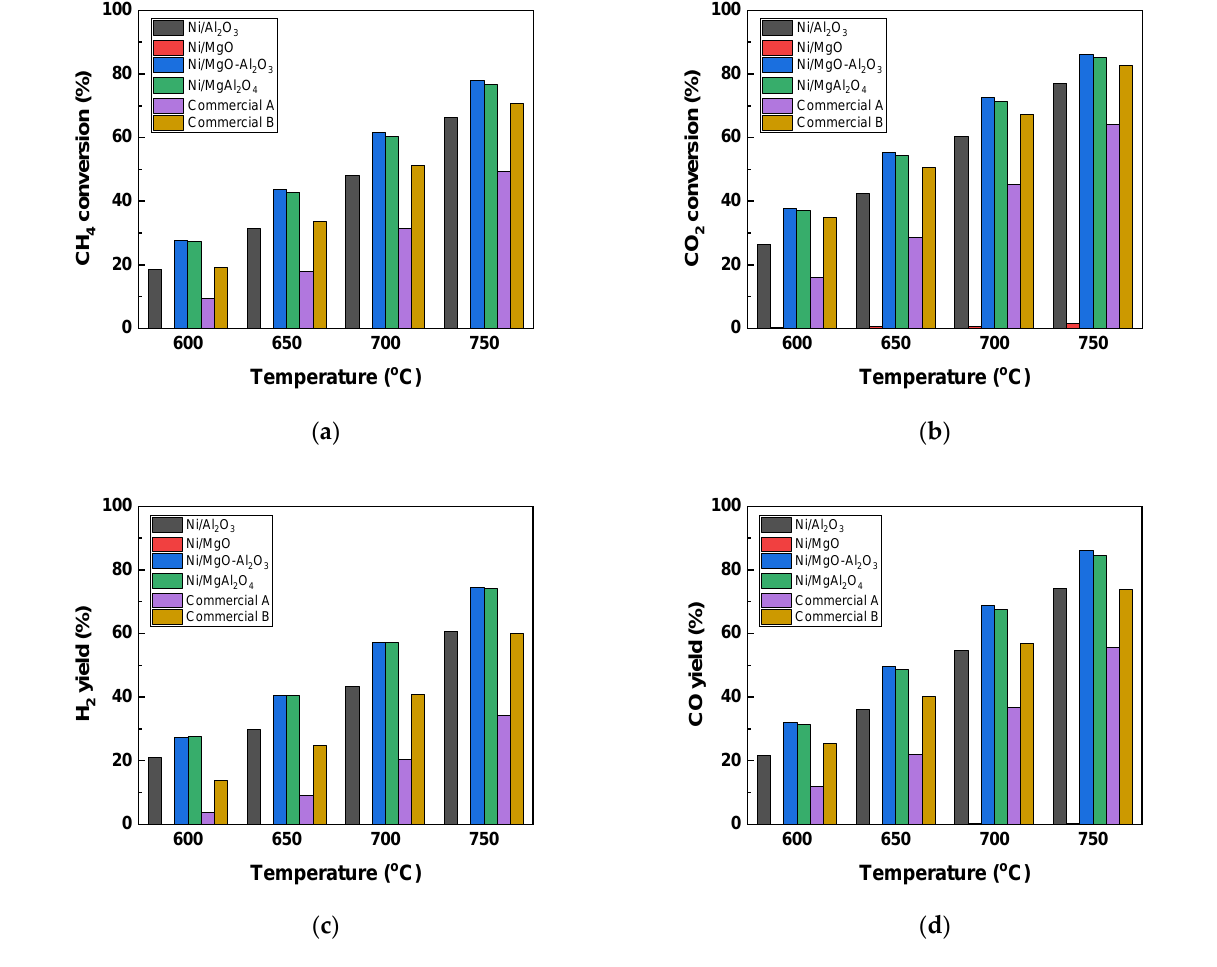
Figure 4. CH 4 conversion ( a ), CO 2 conversion ( b ), H 2 yield ( c ), and CO yield ( d ) with reaction temperature over Ni catalysts (reaction conditions: Temp. = 600–750 ◦ C, CH 4 /CO 2 /N 2 = 1/1/1, GHSV = 144,000 mL/g cat · h). Table 2. H 2 /CO ratio of Ni catalysts with various supports (reaction conditions: Temp. = 750 ◦